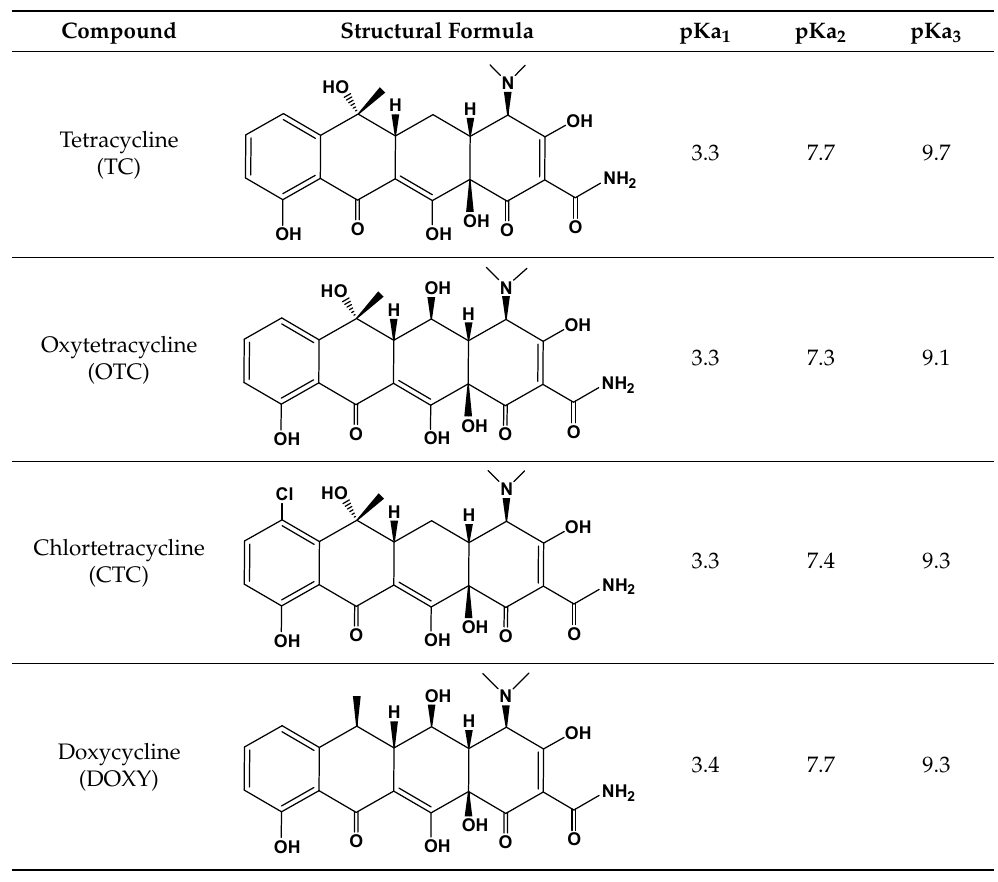
Table 1. Chemical structures and characteristics of the four selected tetracyclines. Compound Structural Formula